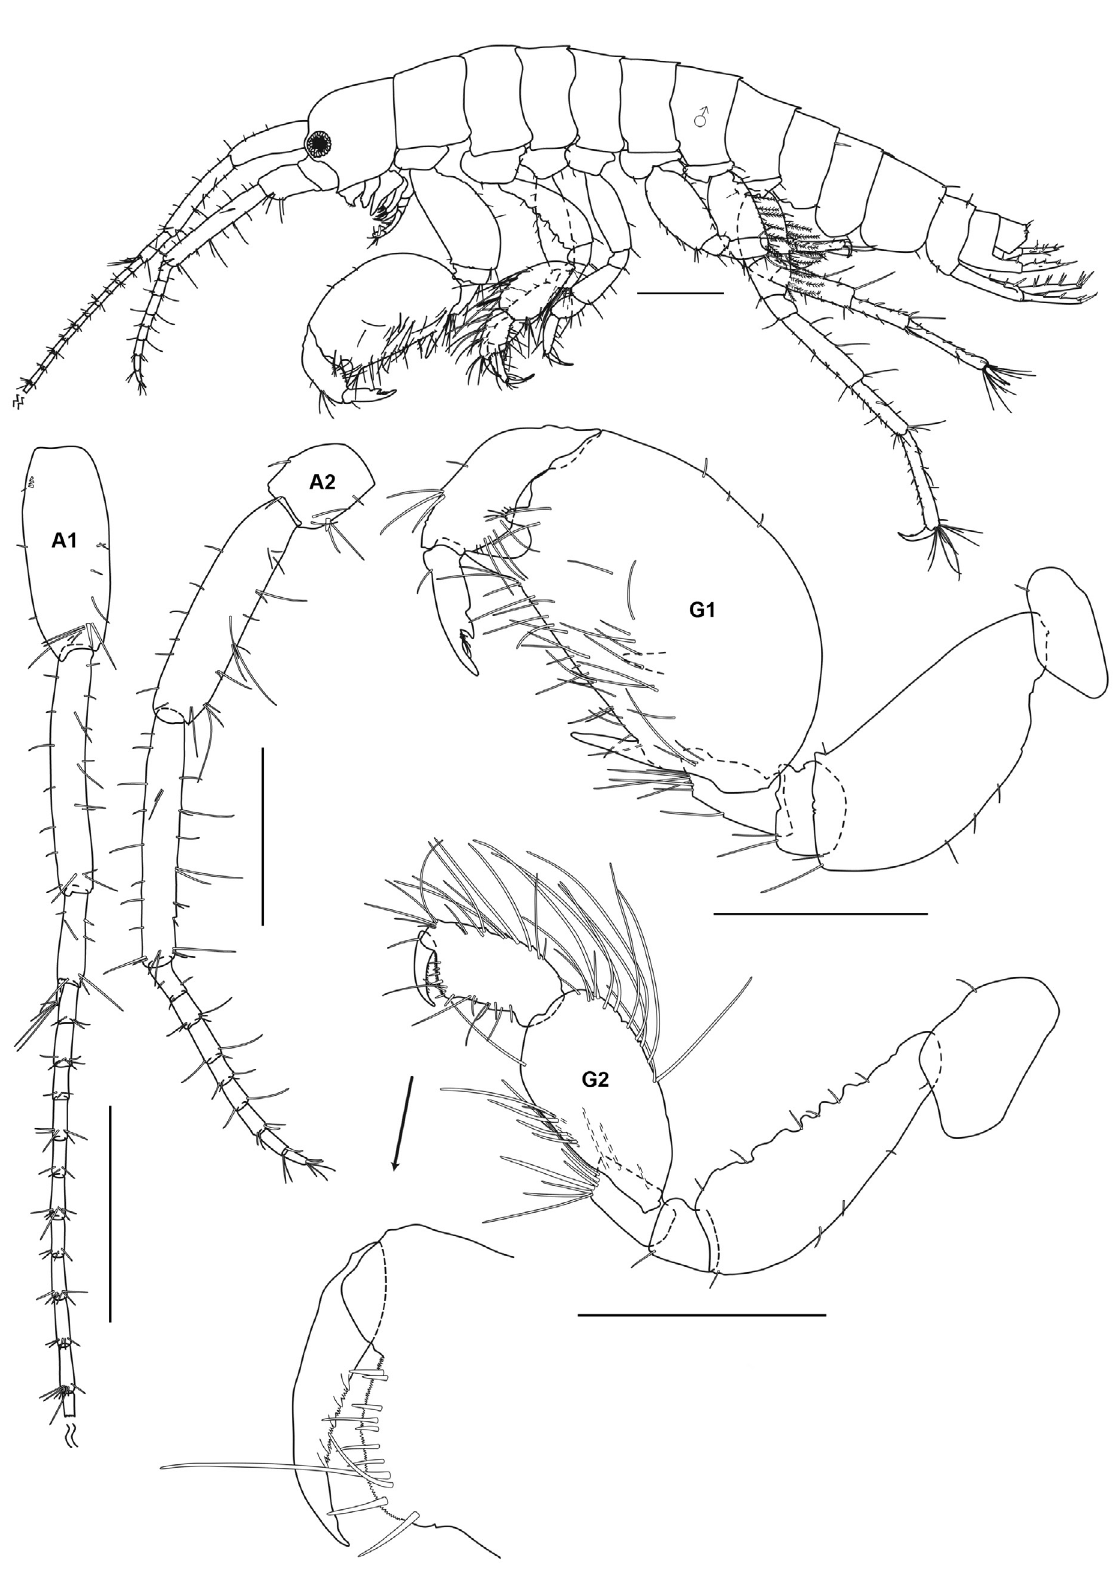
Fig. 3. Grandidierella pawaiensis sp. nov., holotype, ♂ (ZRC 2018.0493). Scale bars: 0.5